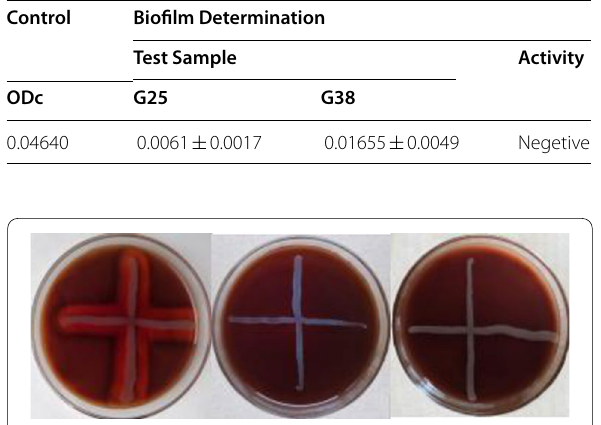
Fig. 4 Hemolytic activity. From left to right, the positive control: Bacillus Zhangzhouensis , G25, G38